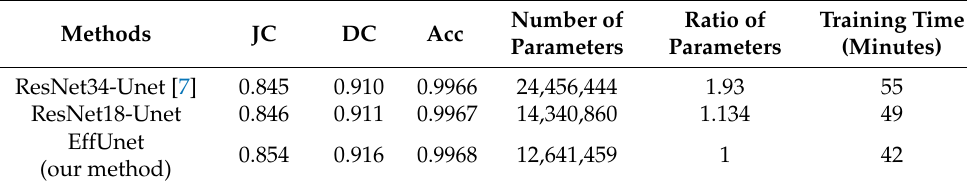
Table 1. Computational efficiency and accuracy of segmentation of cup and disc jointly via EffUnet and ResNet-Unet. The training dataset is ORIGA-A, the test set is ORIGA-B. Ratio of parameters is the ratio of the number of parameters in a method divided by the number of parameters in the EffUnet